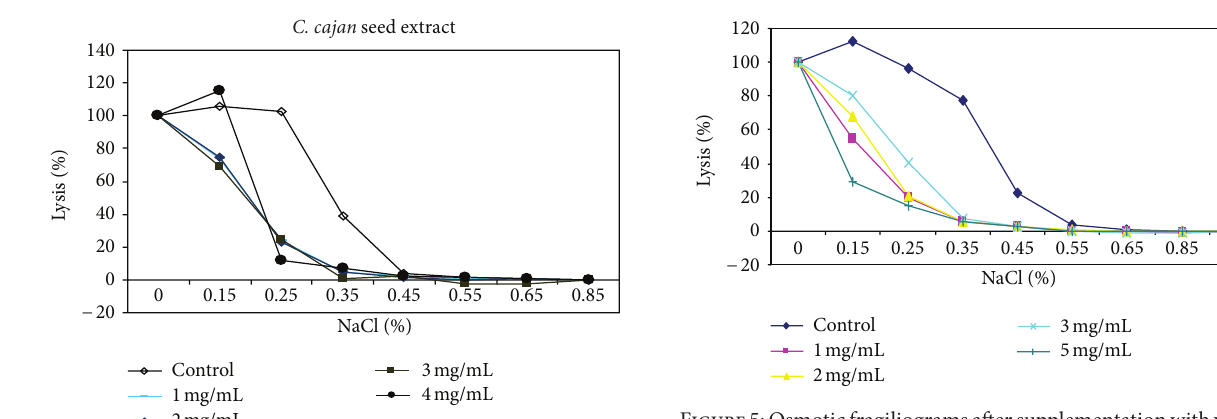
Figure5:Osmoticfragiliogramsaftersupplementationwithvarious concentrations of Parquetina nigrescens plant extract.